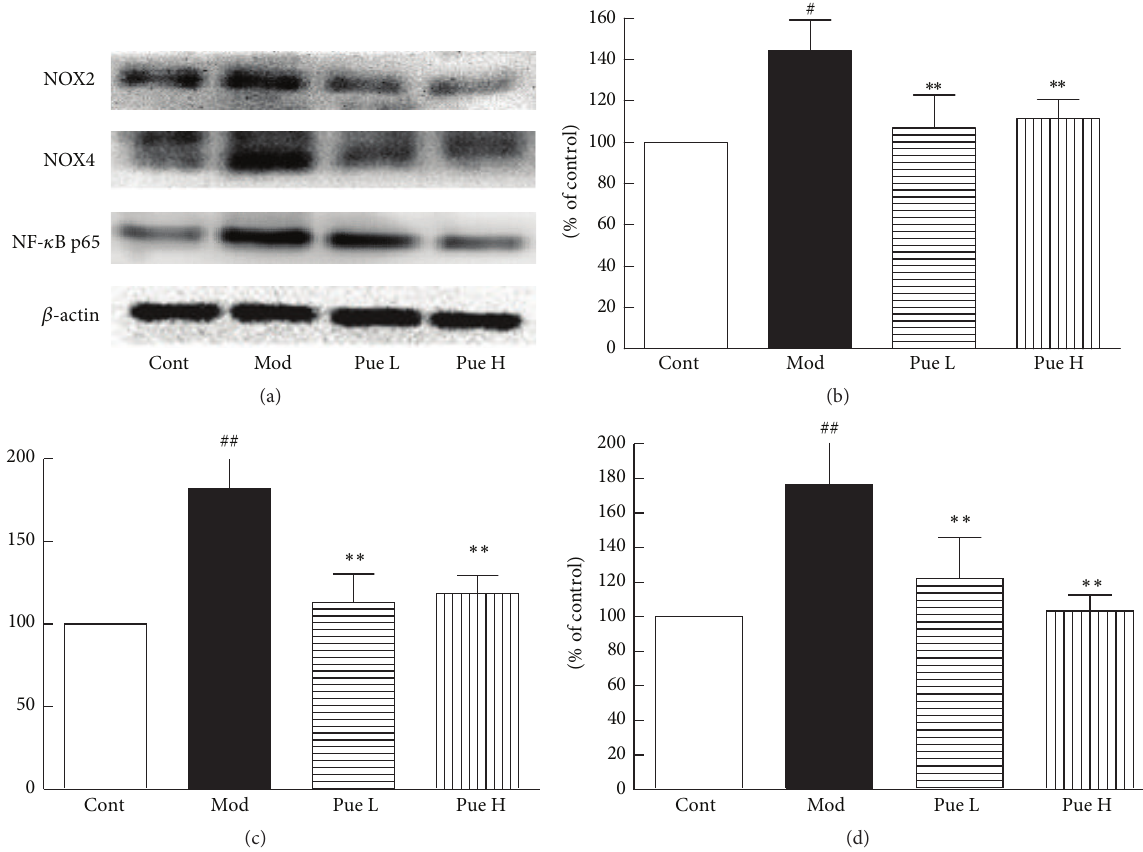
Figure 6: Effect of puerarin on protein expression of NOX2, NOX4, and NF- 𝜅 B p65 (a) in the aorta of STZ-induced diabetic rats; statistical results for NOX2 (b), NOX4 (c), and NF- 𝜅 B p65 (d). # 𝑝 < 0.05 and ## 𝑝 < 0.01 versus Cont; ∗ 𝑝 < 0.05 and ∗∗ 𝑝 < 0.01 versus Mod. Cont, control group; Mod, diabetic model group; Pue L, low dosage of puerarin; Pue H, high dosage of